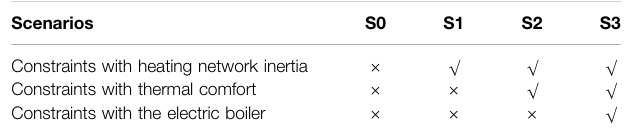
TABLE 2 | Different scenarios.